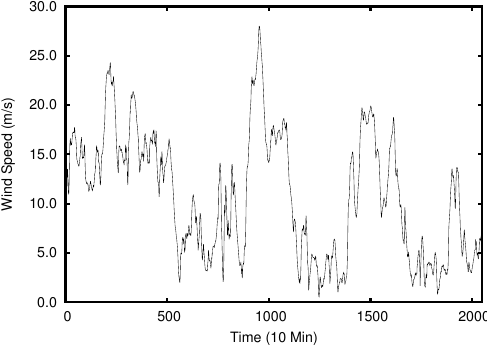
Figure 1. Time series of wind speed at location given by latitude: Fig. 1. Time series of wind speed at location given by Latitude: 34.98420 ◦ N, longitude: 104.03971 ◦ W at 34.98420, Longitude: -104.03971 at 80 metres.